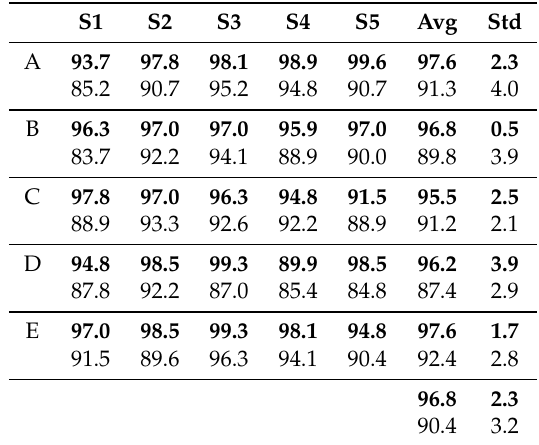
Table 5. Recognition accuracies (%) of the intra-subject evaluation with majority voting over each trial for CSL-HDEMG. Each row corresponds to one subject; the columns, denoted as S1 to S5, correspond to 5 sessions. The values in the second line of each row are those given by Amma et al. [2]. S1 S2 S3